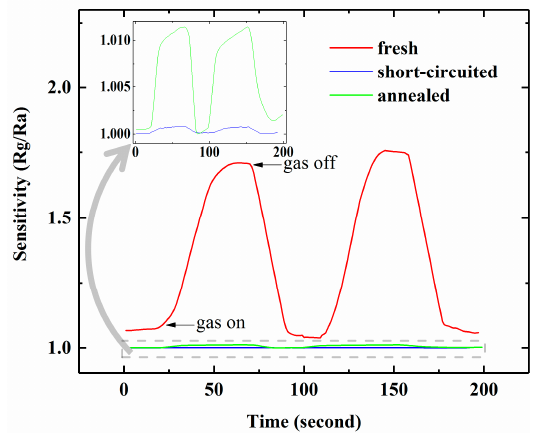
Figure 6. NH 3 response of freshly prepared, short-circuited and annealed sensors at 50 ppm concentration.